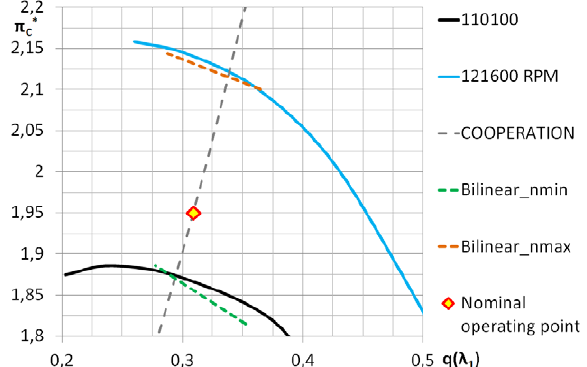
Figure 4. Closeup of compressor characteristic map showing original curves (solid) and bilinear approximations (dashed) in the vicinity of the nominal operating point (based on Garrett turbocharger compressor maps,